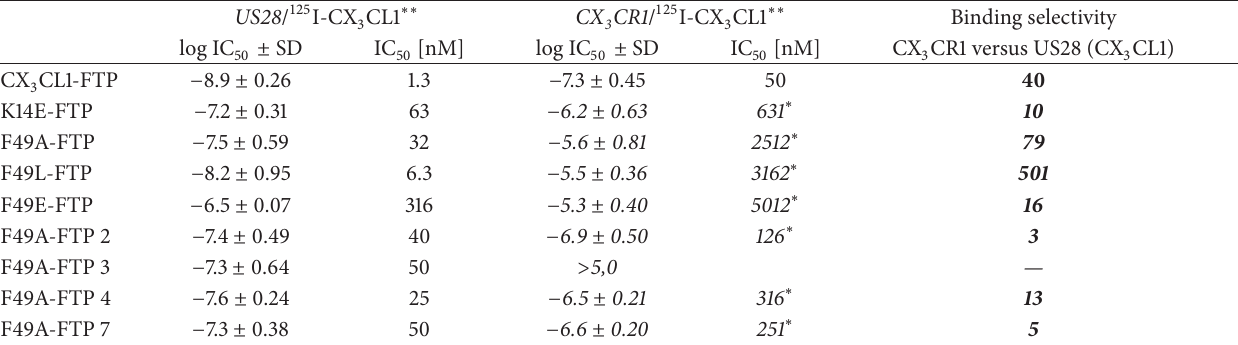
Table 1: Homologous binding experiments testing the binding affinity of the